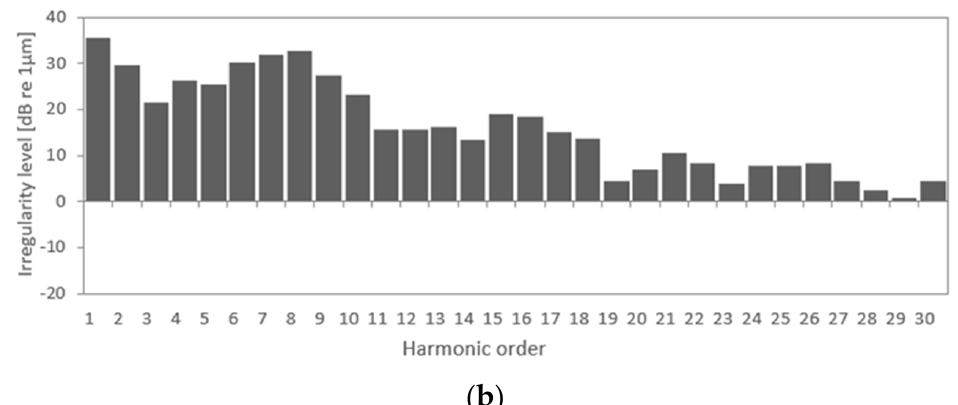
Figure 6. Wheel irregularity amplitude spectra ( Lw ) and harmonic order ( θ ) ( a ) initial polygonal wheel (Johansson et al. [54]), ( b ) damaged polygonal wheel (Cai et al. [55]). For the first group of profiles, the measurement data obtained by Johansson et al. [54] for new wheels with wavelengths comprising 20 harmonics were used (Figure 6a). The wheels have an initial level of polygonization that includes a wide spectrum of wavelengths between 0.135–2.7 m, being the upper limit of the perimeter of the wheel. For the second group of profiles, the measurement values for four wheels with polygonal damage obtained by Cai et al. [55] were considered (Figure 6b). The wheel profiles are characterized by the wavelengths in the first 30 harmonics, with the 6th to 8th harmonic orders being